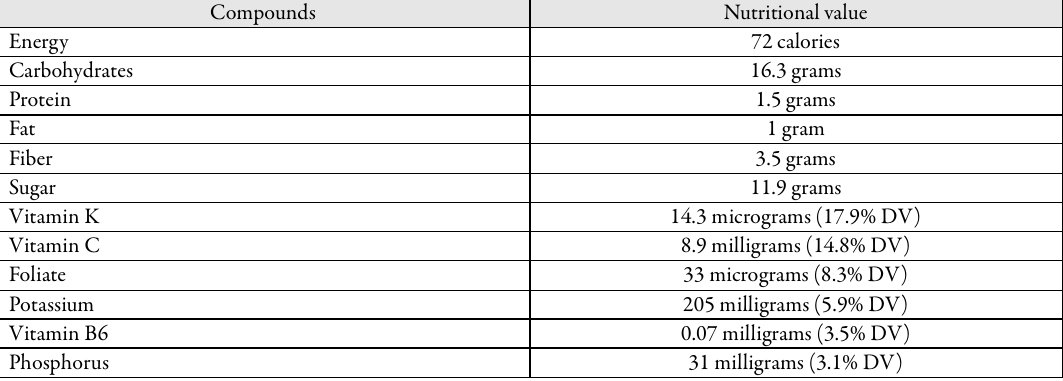
Table 3. Nutritional values of pomegranate seeds (Khan et al .,